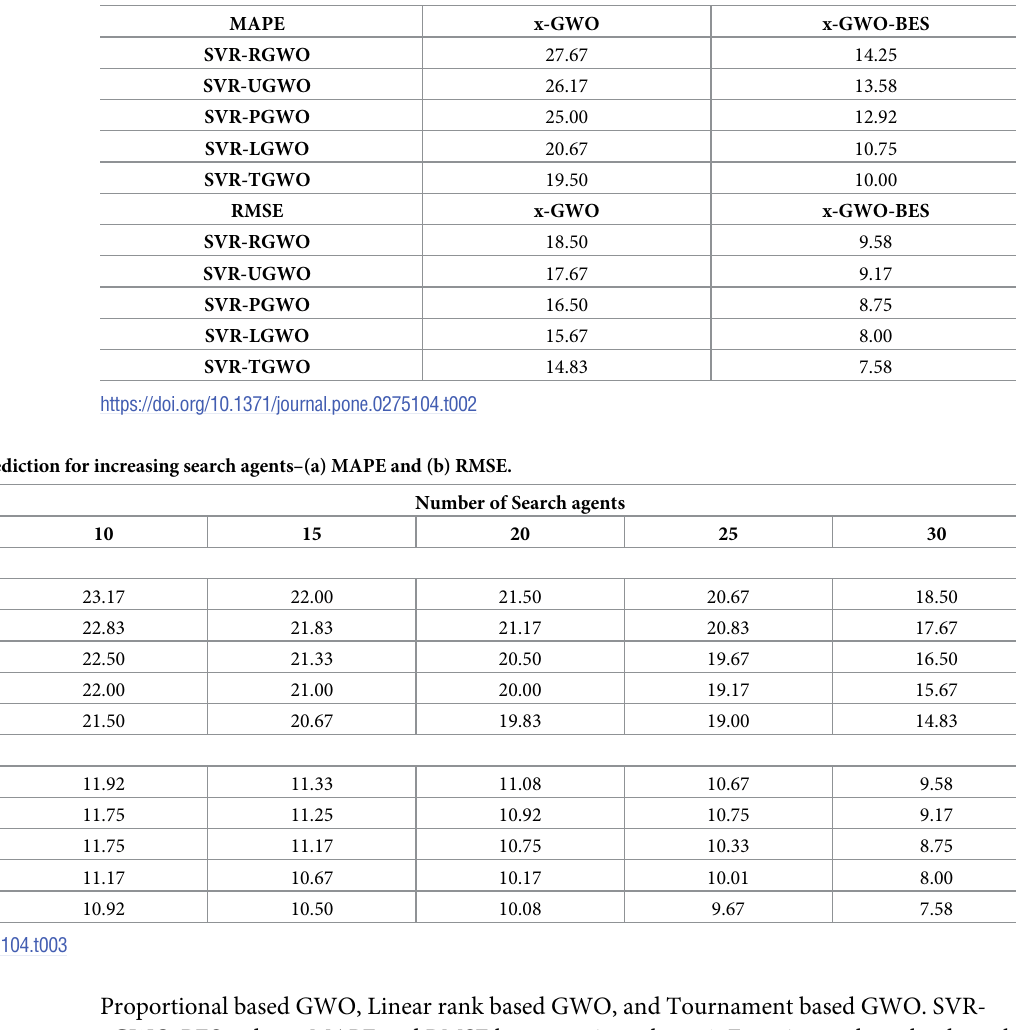
Proportional based GWO, Linear rank based GWO, and Tournament based GWO. SVR- xGWO-BES reduces MAPE and RMSE by approximately 48%. Experimental results show that number of search agents produce reduced error performance. In a pack of grey wolves,